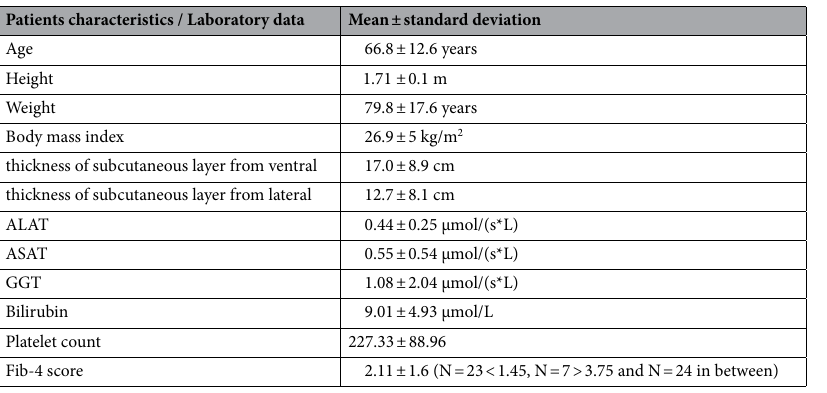
Table 3. Patients characteristics and laboratory